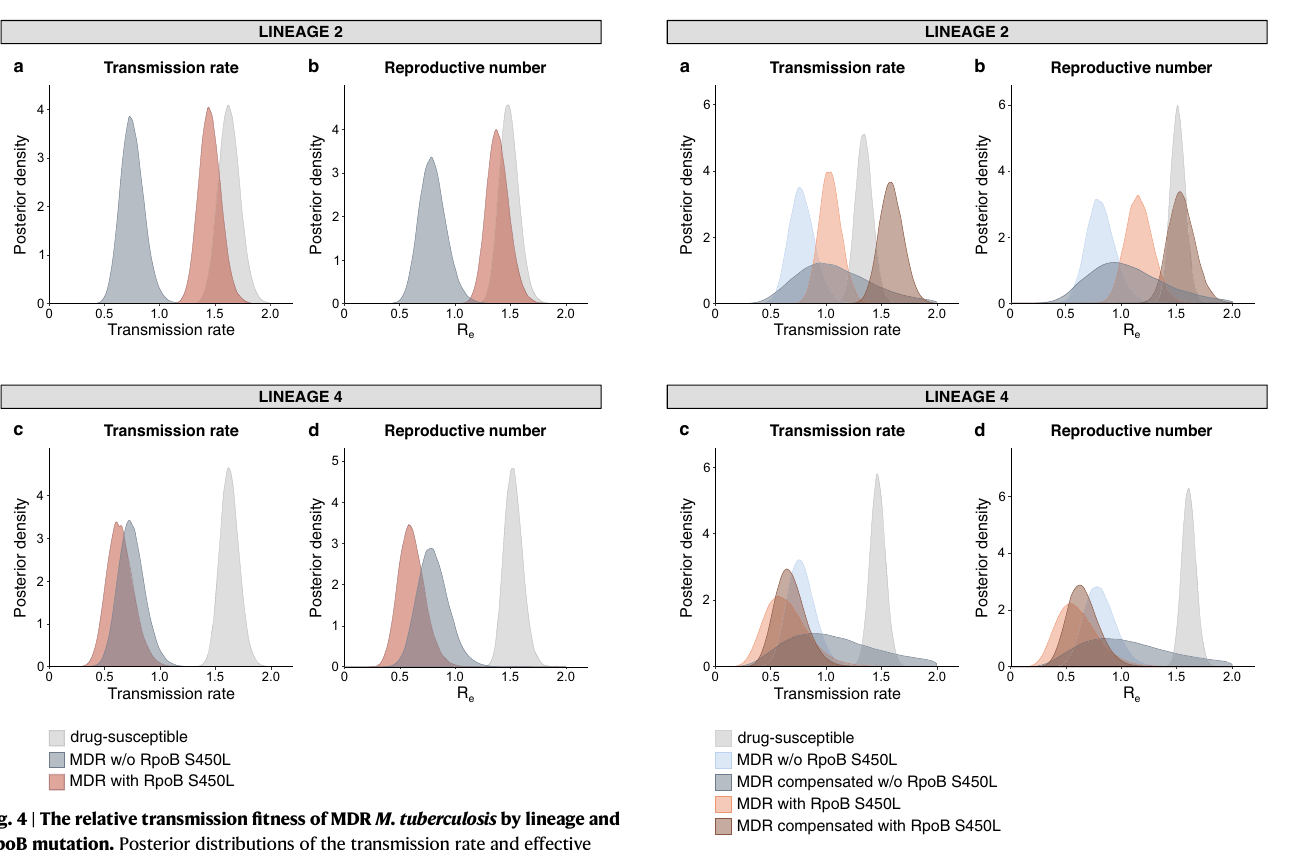
Fig. 5 | The relative transmission fi tness of MDR M. tuberculosis by lineage, RpoB mutation and the presence or absence of compensatory mutations. Posterior distributions of the transmission rate and effectivereproductive number of drug-susceptible strains and MDR strains with or without the RpoB S450L mutationand compensatorymutations,estimatedby fi tting a fi ve-type birth-death model on a random subset of sequences belonging to L2 ( N =374) ( a , b ) and L4 ( N =228) ( c , d